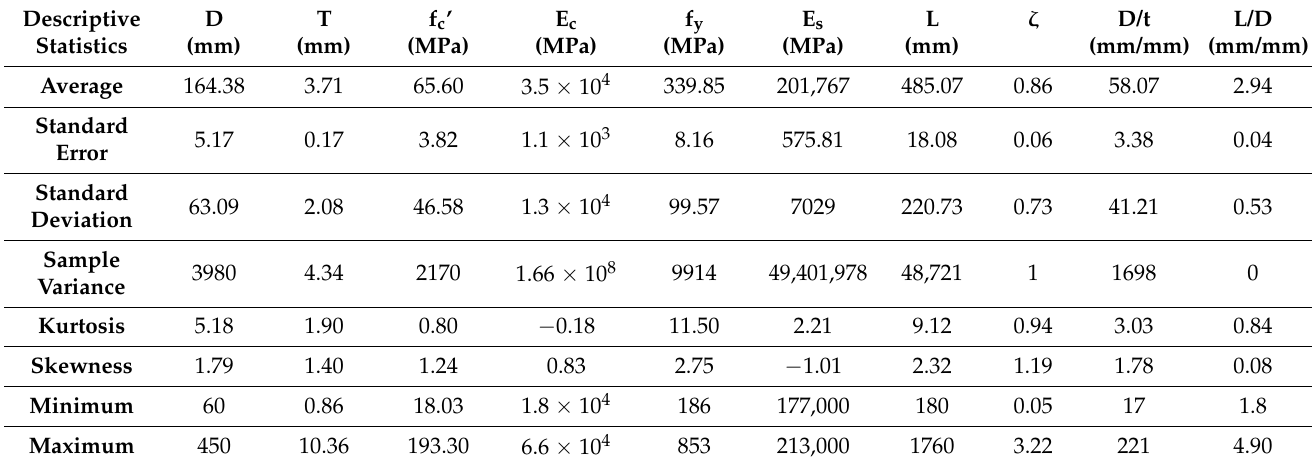
Table 2. Descriptive statistics of the input